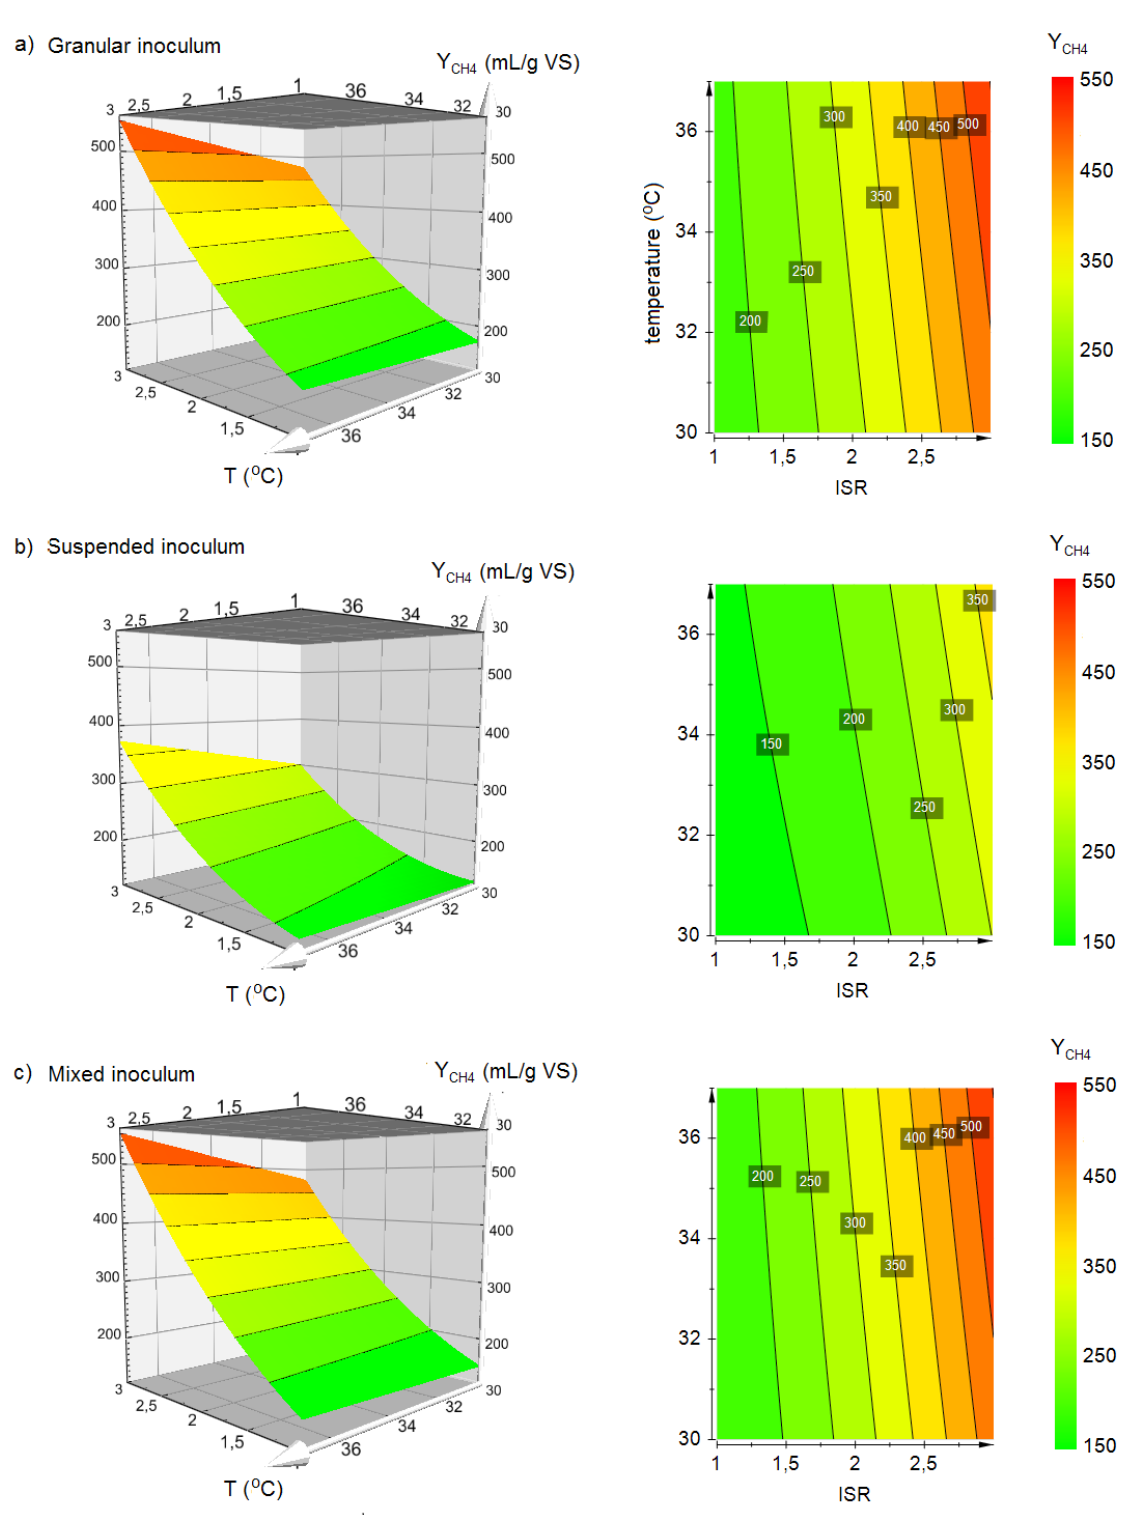
Figure 2. Response surfaces and the corresponding contour diagrams of the specific methane production in function of ISR and temperature for the three inoculum types tested: a) granular inoculum b) suspended inoculum and c) mixed